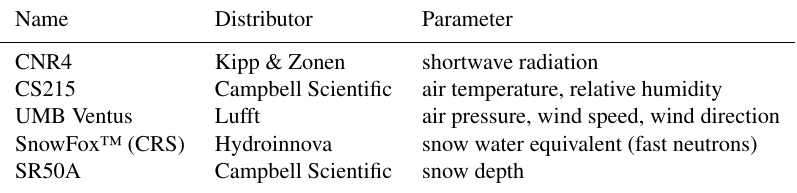
Table 1. Sensors installed at Plaine Morte.